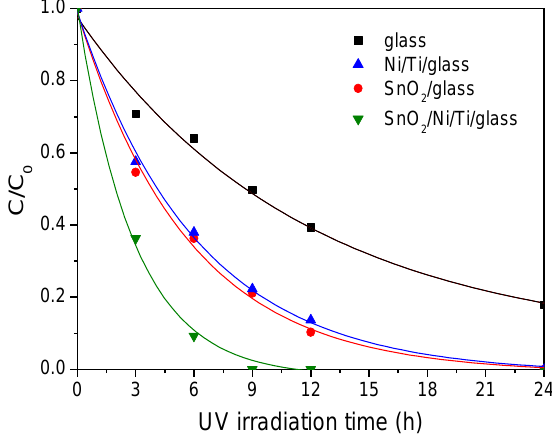
Figure 2. Residual MB concentration (C/C 0 ) versus UV irradiation time for characterizing photocatalysis of 250 °C-deposited TiO 2 films on various indicated underlying materials.